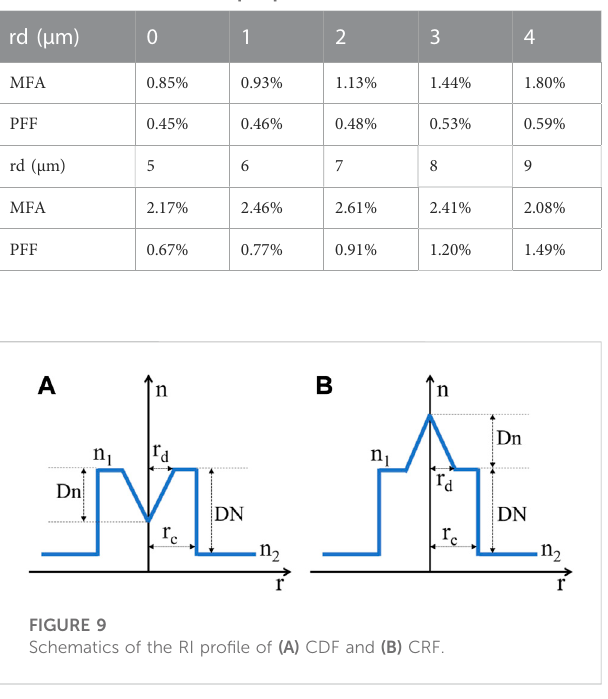
TABLE 2 DF under different dip depths.